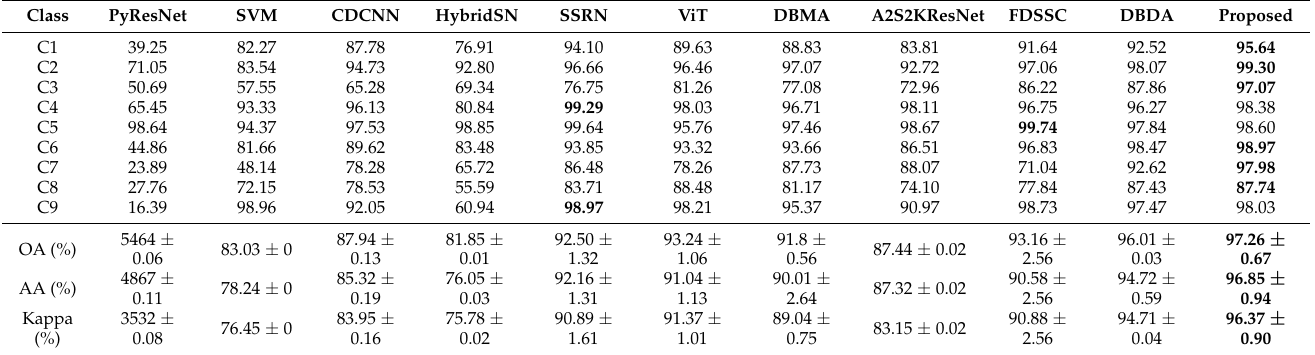
Figure 9. The overall accuracy and classification maps of different methods on UP dataset: ( a ) A2S2KResNe (87.44%); ( b ) DBDA (96.01%); ( c ) DBMA (91.8%); ( d ) PyResNet (54.64%); ( e ) SSRN (92.50%); ( f ) ViT (93.23%); ( g ) SVM (83.03%); ( h ) HybridSN (81.85%); ( i ) DCCNN (87.94%); ( j ) FDSSC (93.16%); ( k ) proposed (97.26%). Table 6. KPIs (OA, AA, and kappa) on the Pavia University (UP) dataset with 0.5% training